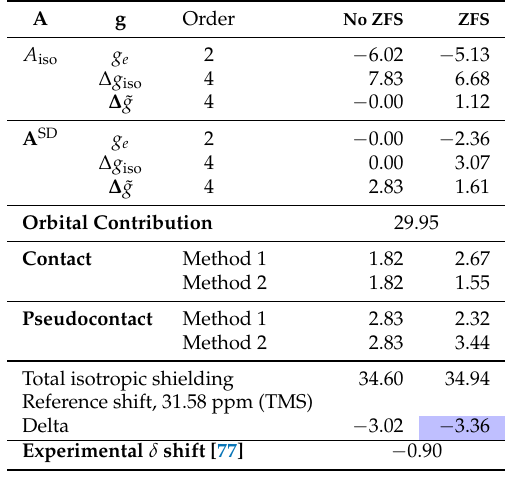
Table 8. Calculated 1 H pNMR shifts for U(C 5 Me 5 ) 3 in ppm at 298 K. The final, ZFS corrected, computational values are highlighted.